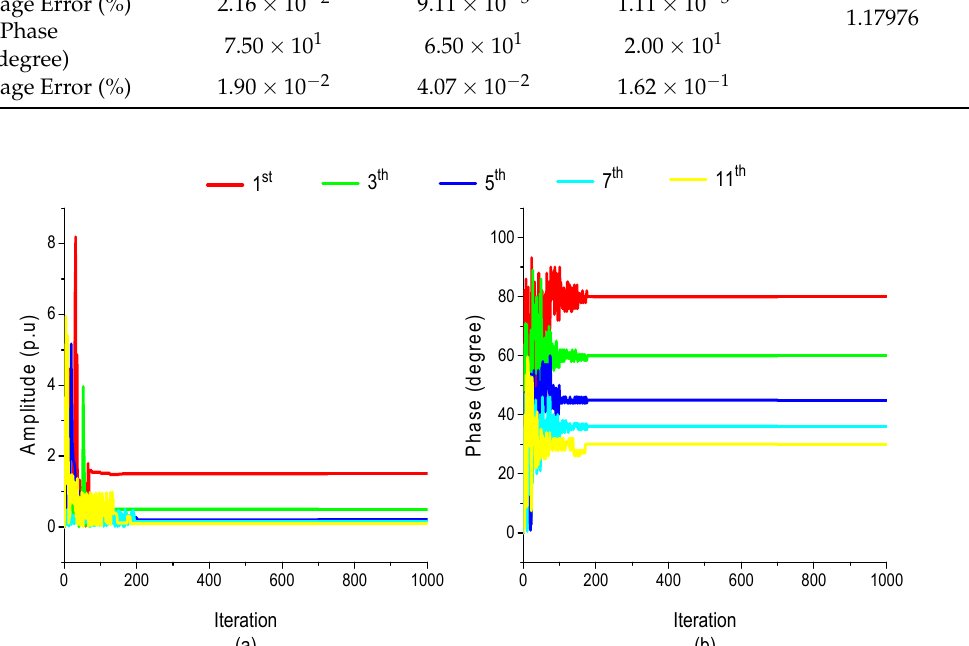
Figure 8. Variation in estimated ( a ) amplitude and ( b ) phase in the course of iterations for the first 5 odd